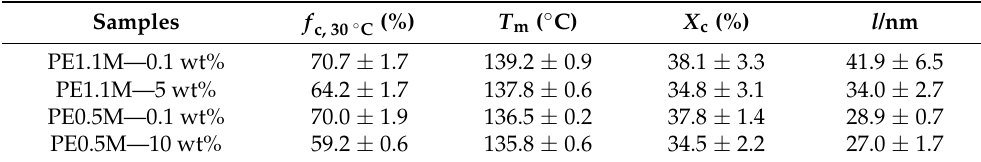
Table 1. Melting point ( T m ), mass crystallinity ( X c ) and lamellar thickness ( l ) of all the samples obtained from DSC. The fraction of the crystalline phase at 30 ° C ( f c, 30 °C ) was fitted from the low- field NMR.